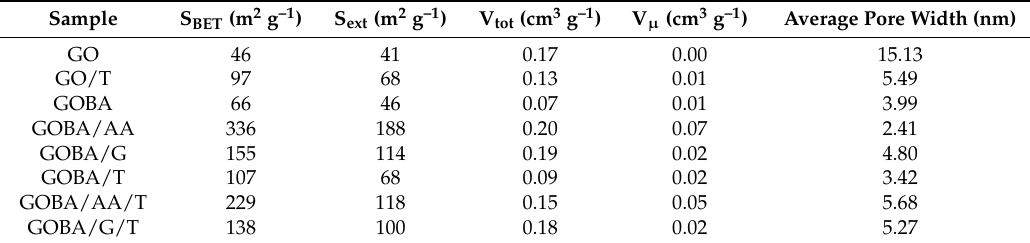
Table 2. Textural characterization of rGO samples.